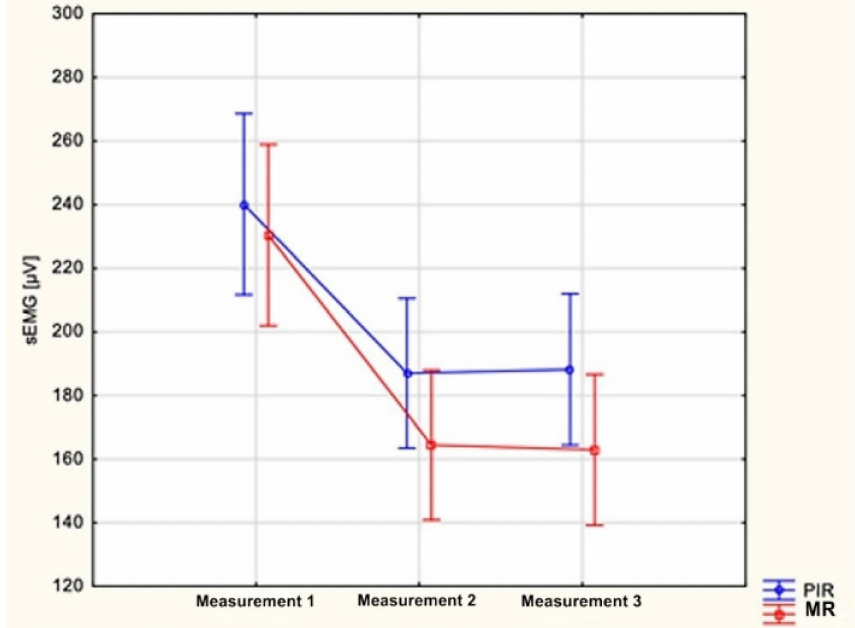
Figure 8. Comparison of changes in the mean values of electric potentials [ µ V] of left masseter muscles measured during electromyographic examinations between group I (PIR) and group II (MR); p =